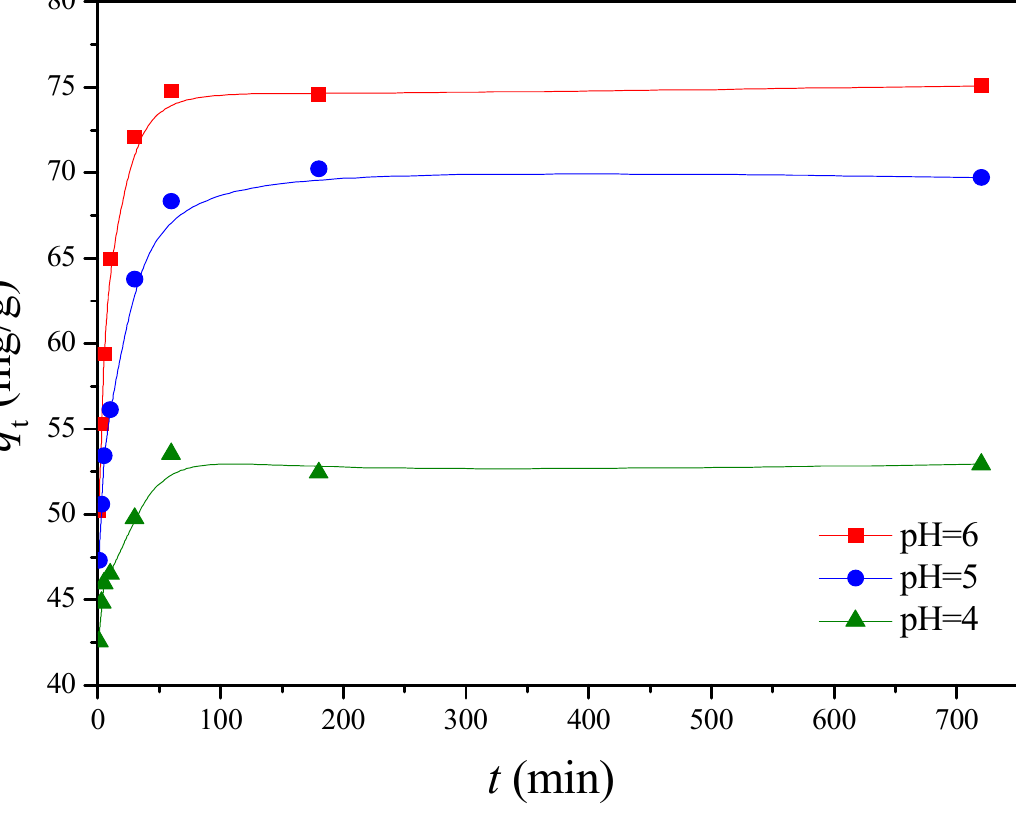
Figure 6. Effect of pH on the adsorption of Cu(II) onto G1H20 nanoparticles at 60 °C.